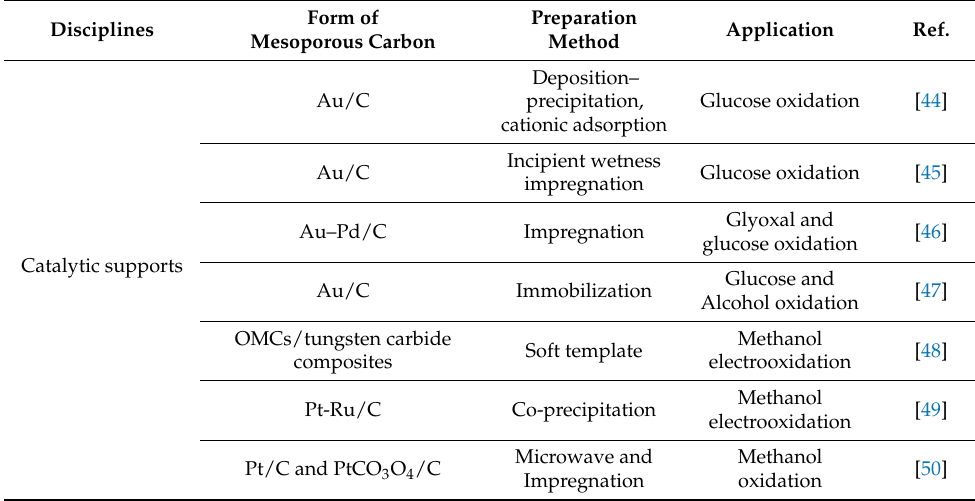
Table 1. Application of mesoporous carbon in various scientific